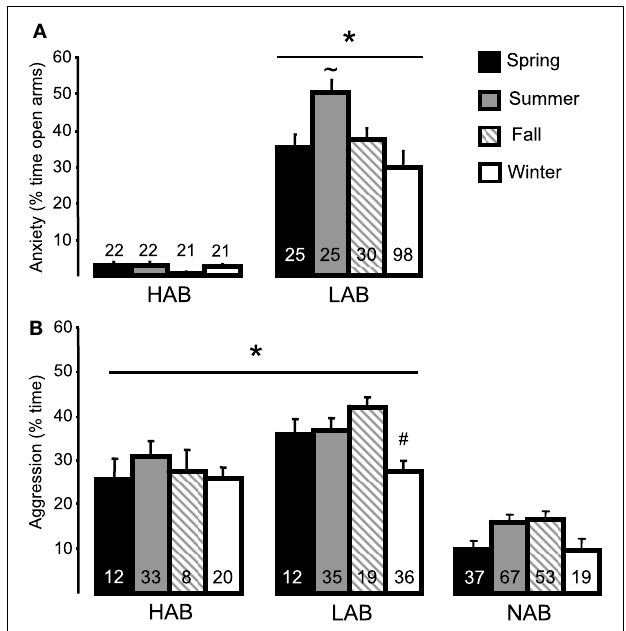
FIGURE 2 | (A) Anxiety-related behaviour on the EPM as refl ected by the percentage of time on the open arms measured in 9-week-old male HAB and LAB rats (* p < 0.05 vs. HAB at any time, ~ p < 0.05 vs. other 3 seasons), and (B) aggressive behaviour of 16- to 22-week-old male HAB, LAB, and NAB rats (* p < 0.05 vs. NAB, # p < 0.05 vs. summer and fall) during the four seasons. Numbers in columns indicate group size. Data are presented as mean +